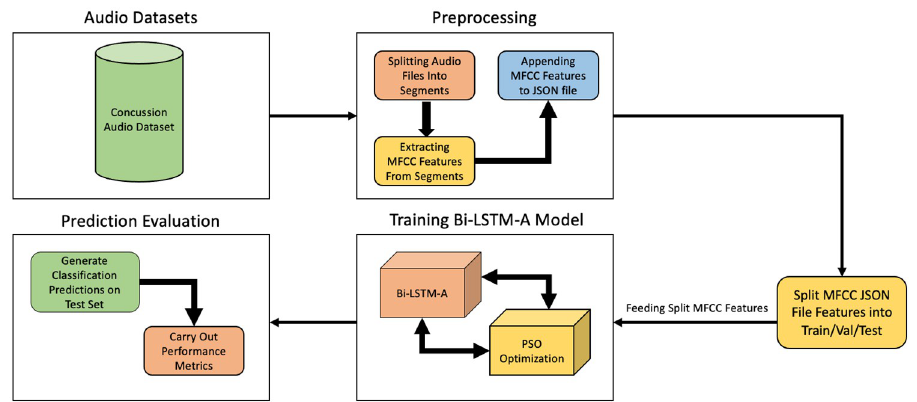
Fig 2. Bi-LMST-A model from audio dataset clockwise, displaying steps from the pre-processing phase to prediction evaluation phase.